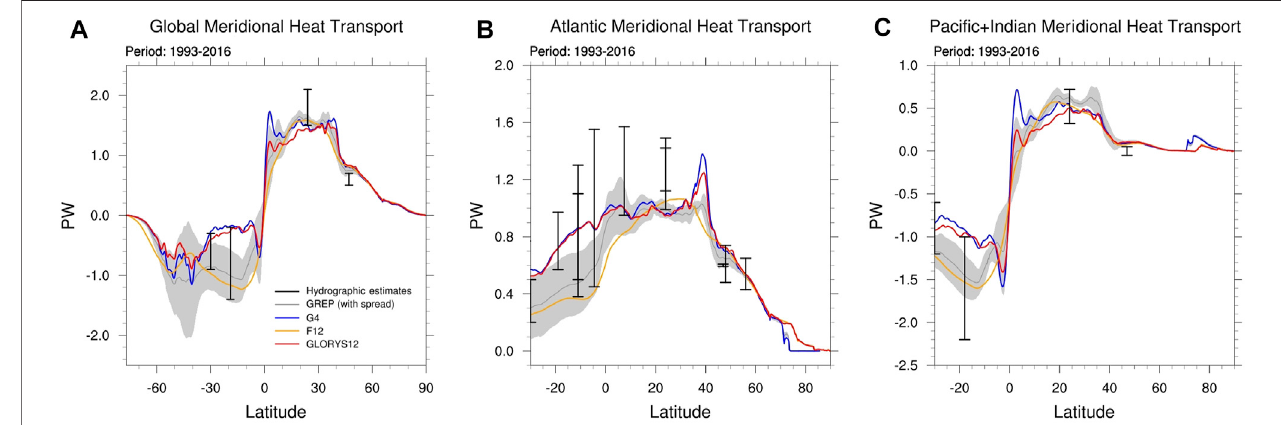
FIGURE 8 | Mean Meridional Heat Transport for the 1993 – 2016 period for Global Ocean (A) , Atlantic Ocean (B) and Paci fi c + Indian Oceans (C) . GLORYS12 is plotted in red, F12 in orange, G4 in blue, GREP ensemble product in grey and hydrographic estimates in black. Units are PW.